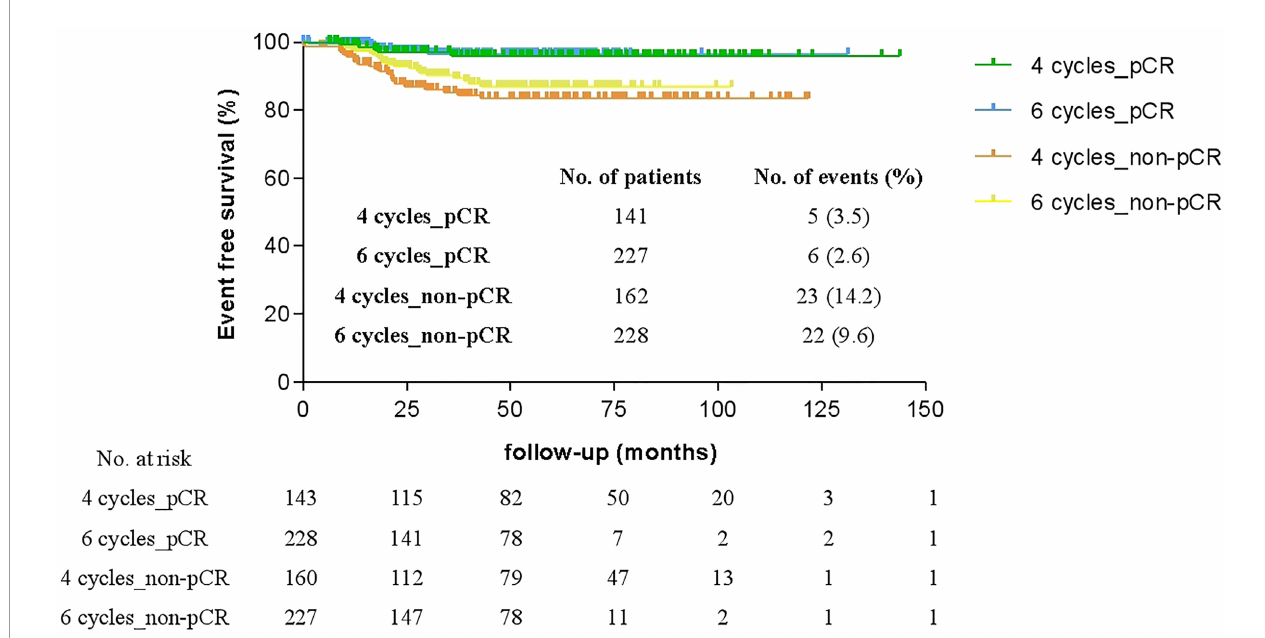
FIGURE 4 | Comparison of four-year event-free survival (EFS) of patients who achieved pathologic complete response (pCR) or with residual disease (non-pCR) after four or six cycles of neoadjuvant